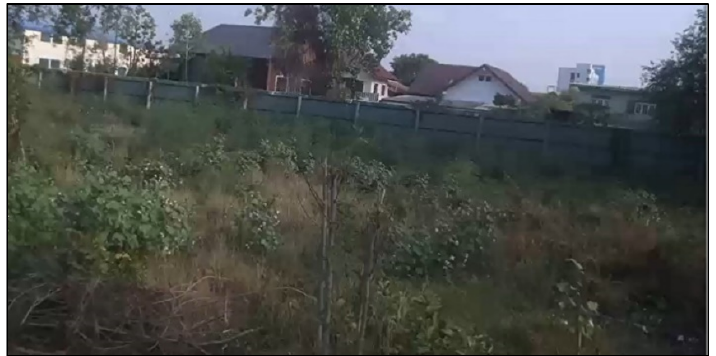
Figure 27. Experimental field for fault detection test.